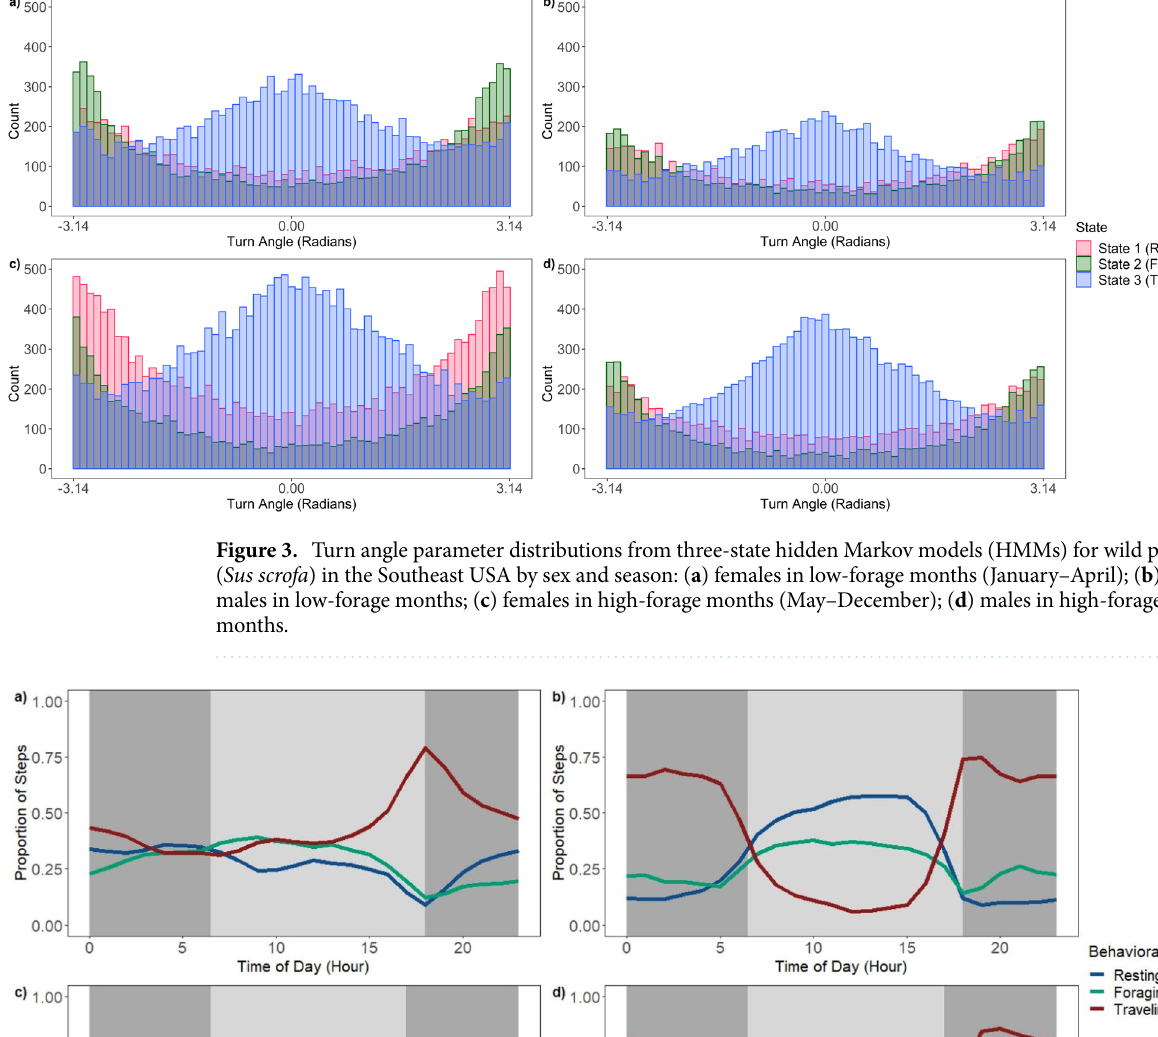
roads. Males demonstrated more diversity in selection while foraging in the low-forage season including shrub/ herbaceous, bottomland hardwoods, and both secondary and primary roads; however, during the high-forage season, males concentrated foraging in areas near or in bottomland hardwood vegetation (Fig. 6). During the high-forage season, males exhibited a 23% decrease in use for every 100 m farther from bottomland hardwoods. In addition, the selection for areas with a high percentage of canopy cover was consistent between sexes and seasons within the foraging behavioral state (Fig. 6). When traveling, resource selection was similar between seasons for females and males. Females selected pri- mary roads and bottomland hardwoods when traveling in both seasons, with the addition of upland hardwoods in the high-forage season (Fig. 6). Males selected shrub/herbaceous vegetation, primary and secondary roads,